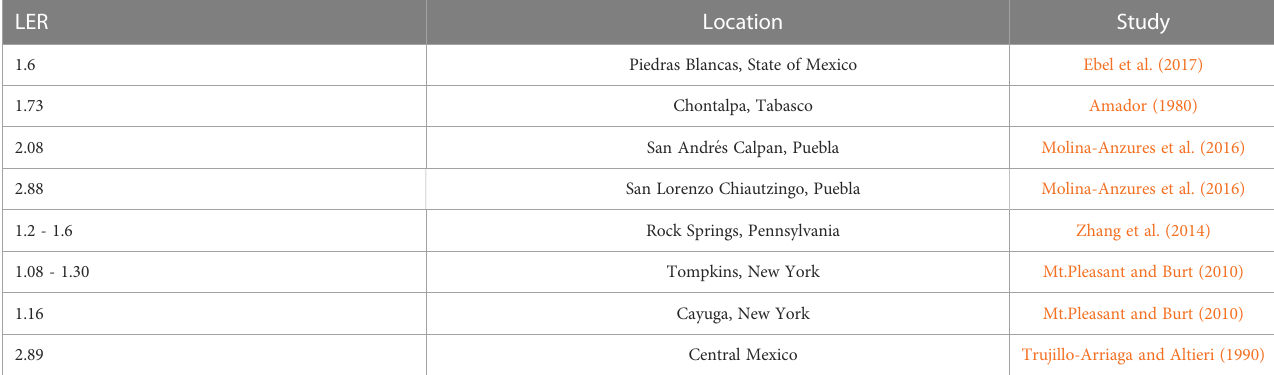
TABLE 2 Land Equivalent Ratio (LER) reported in studies on milpa as a maize, bean and squash association system, compared to monocultures of the same crops.